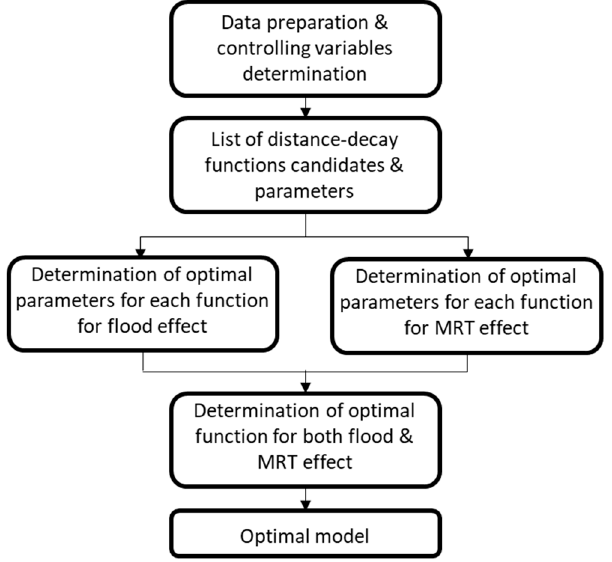
Figure 3. Conceptual framework